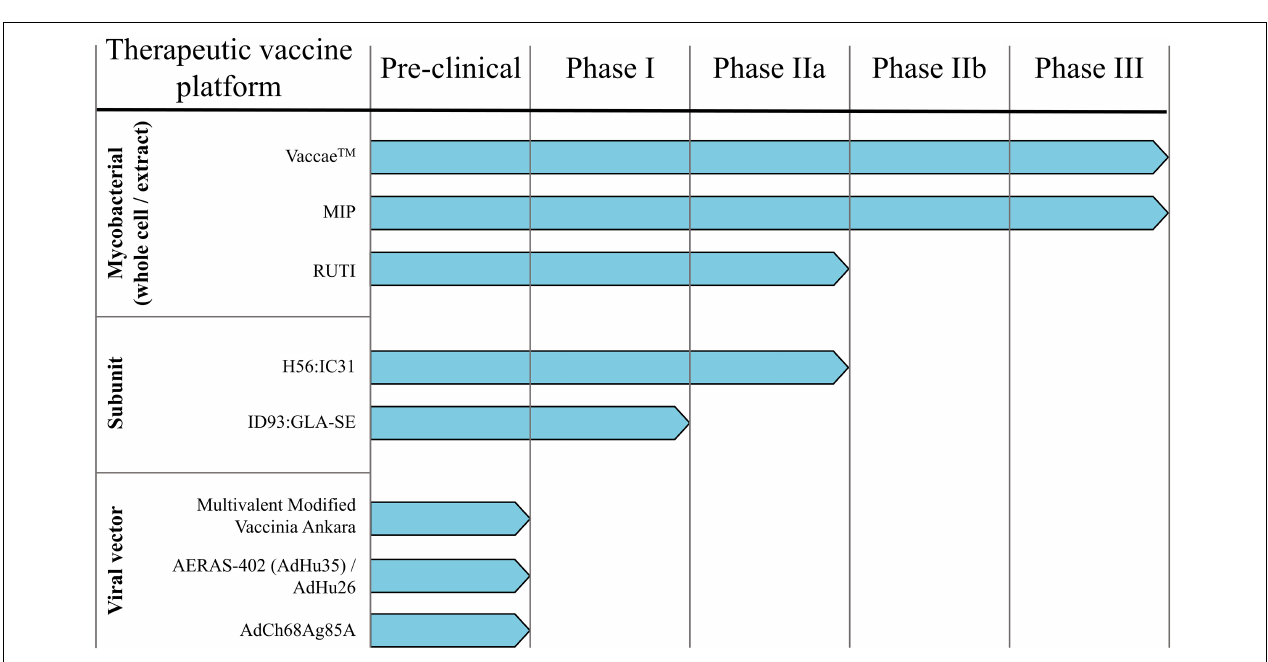
Frontiers in Immunology |